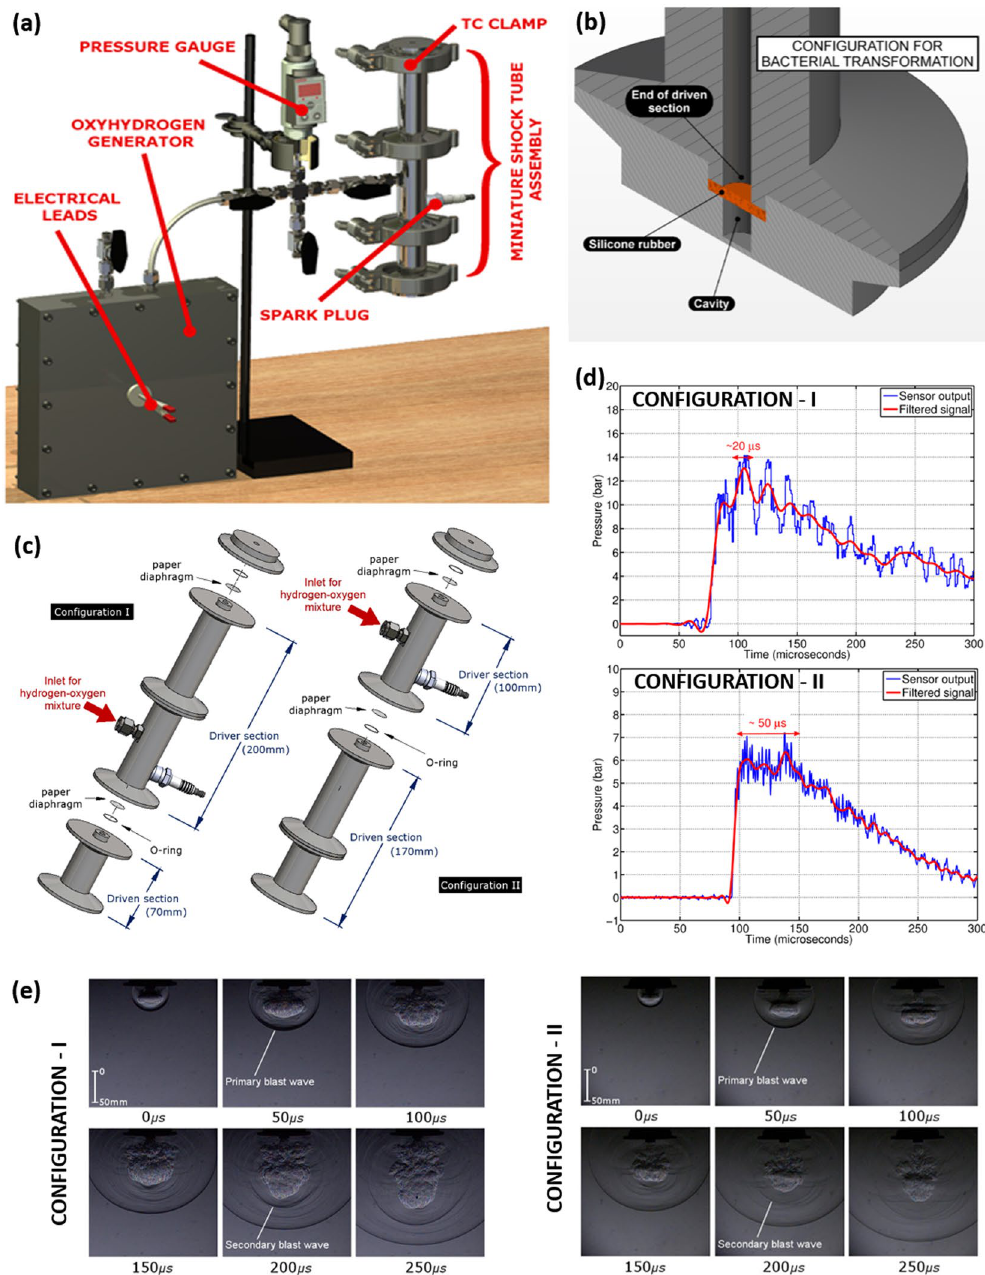
Figure 1. The oxyhydrogen-driven miniature shockwave device for bacterial transformation. (a) Schematic of the oxyhydrogen-driven miniature shockwave device for bacterial transformation, (b) Cross-sectional view of the end of the shock tube showing the cavity for biological sample, (c) Shock tube configurations used for the study. Different lengths of driver and driven section are depicted, (d) Pressure signal recorded for the two configurations using a sensor flush mounted to the wall of the driven section placed 12 mm from the end of the shock tube, (e) High speed Schlieren images of the blast wave recorded from the open end of the shock tube operated using the two